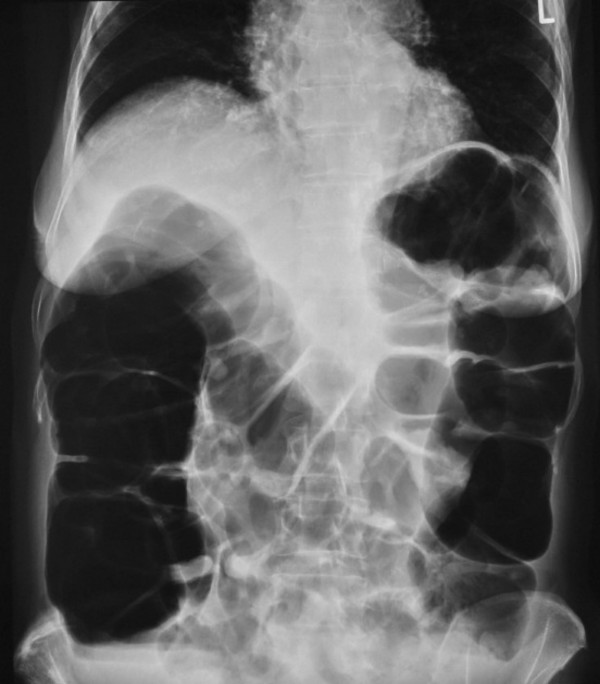
Abdominal X-ray of patient 1 at first presentation. Note heavily dilated colon frame.